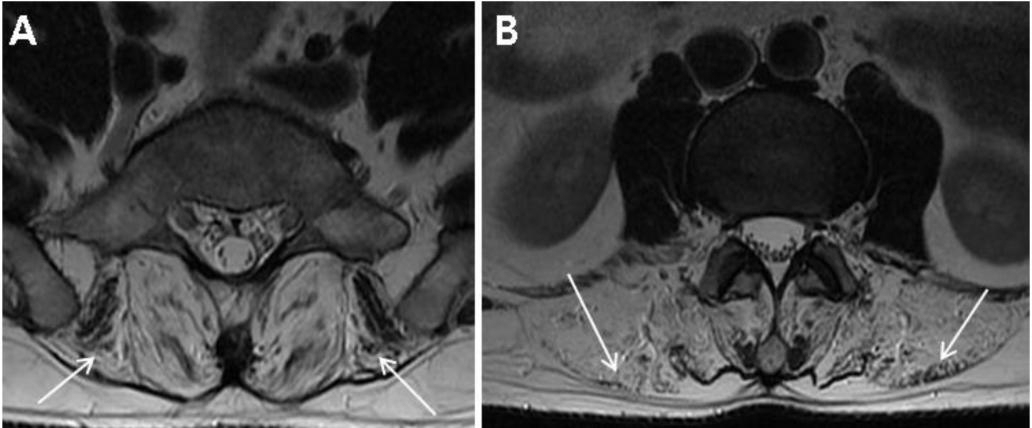
Figure 5. Follow-up magnetic resonance image (MRI) of the lumbar spine. ( A ) At 2 years after the onset of S1 radiculopathy, near-complete resolution of L5-S1 extruded disc and progression of fatty degeneration of the erector spinae (arrows). ( B ) Fatty degeneration of the erector spinae (arrows) at the L3 vertebral body level was also